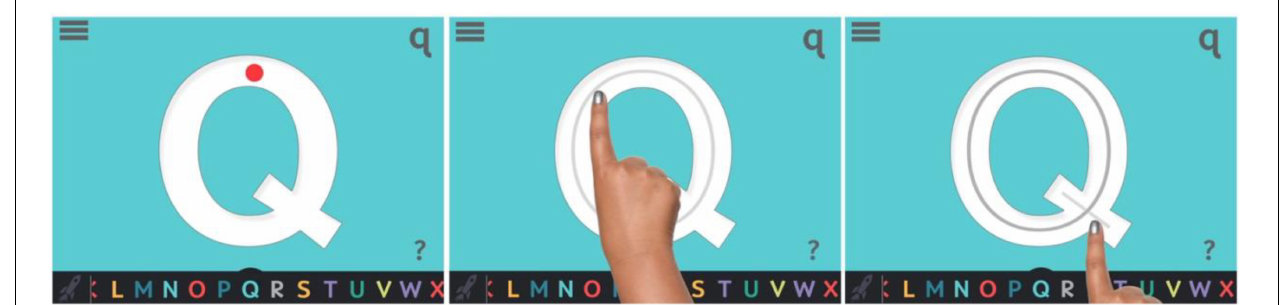
FIGURE 5 | Trace hint animations